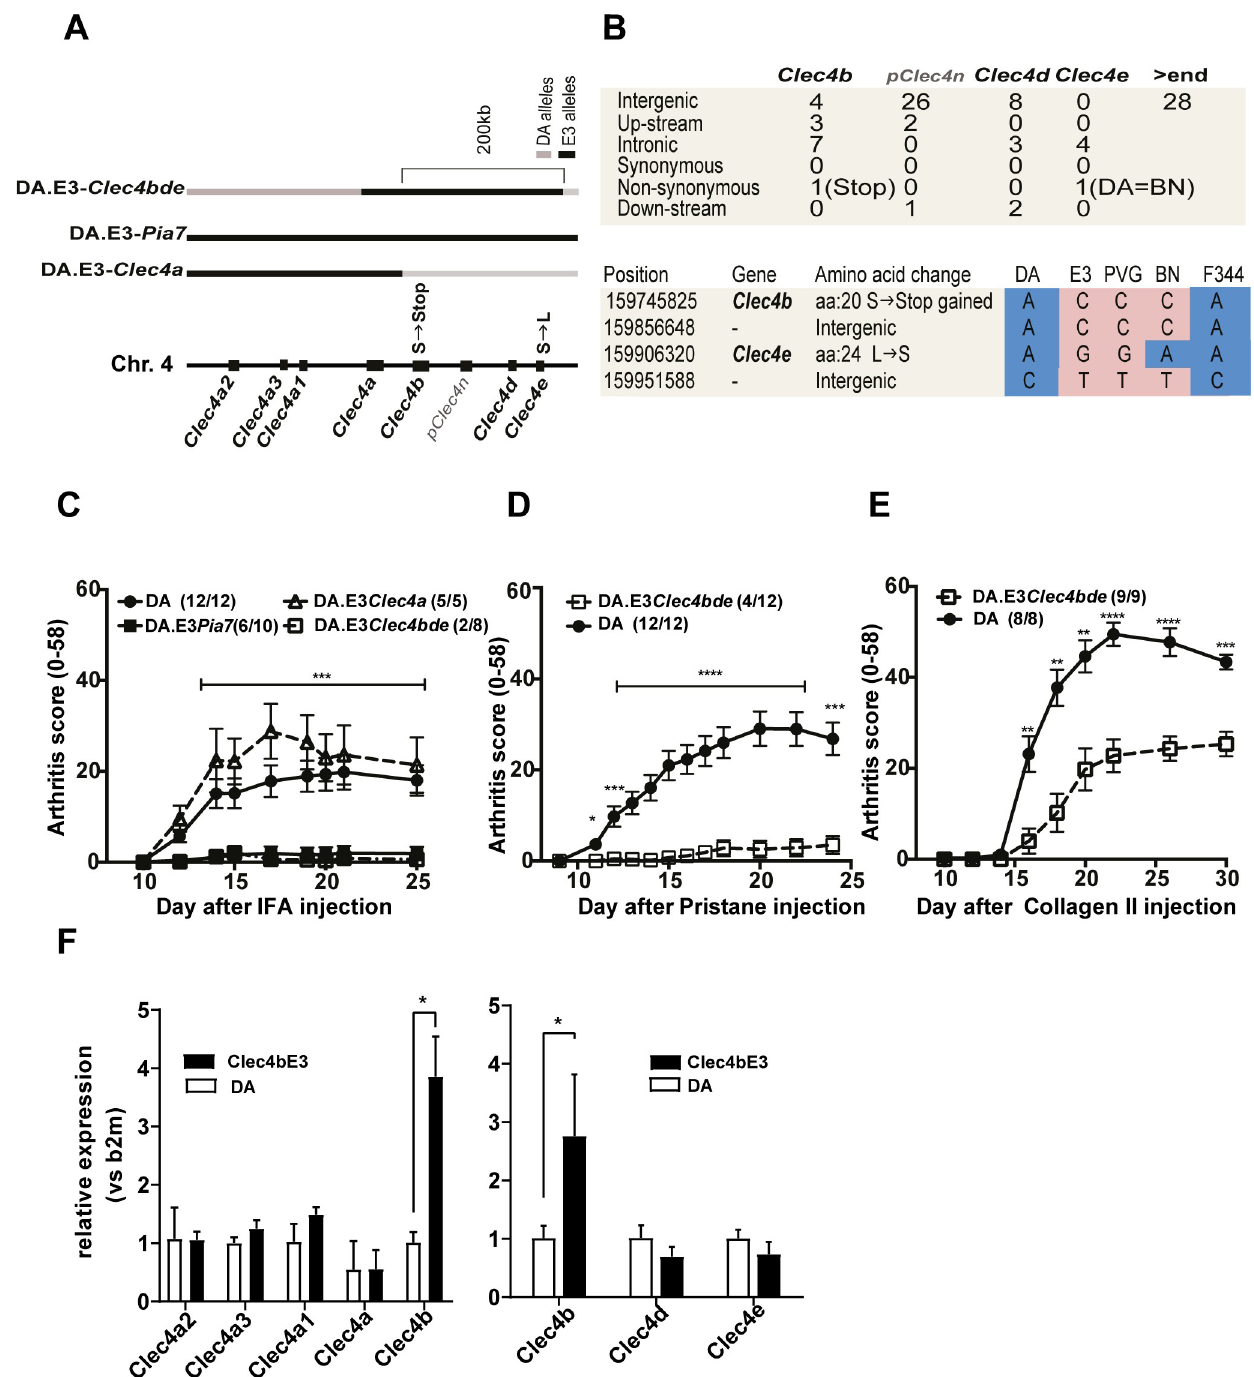
Fig 1. Identification of the arthritis-regulating gene in the Oia2/Pia7/Cia13 locus on rat chromosome 4. a) An illustration of the distribution of the 8 C- type lectin genes across the APLEC interval on rat chromosome 4 and the congenic fragments with genomic regions harboring arthritis-susceptible DA alleles (grey) and arthritis-protective E3 alleles (black) for the three congenic strains DA.E3- Pia7 to the far right, DA.E3- Clec4a to the left of the chromosome and DA.E3- Clec4bde to the far left. b) An illustration of the distribution of SNPs across the DA.E3- Clec4bde congenic fragment[6] and the Clec4bde encoded genes, together with an illustration of the two non-synonymous SNPs and nearby SNPs in five different inbred strains including the reference rat strain BN. c) OIA development in DA strain and the 3 congenic strains. d) PIA development over time in the original DA strain and DA.E3- Clec4bde congenic. e) CIA development over time for the DA strain and the DA.E3- Clec4bde strain. Significance stars illustrate Mann. Whitney Test � = p < 0 . 05 , �� = p < 0 . 01 , ��� = p < 0 . 001 ���� = p < 0 . 0001 and SEM. f) Gene expression of all APLEC encoded genes for DA and Clec4b E3 in na ï ve splenocytes. House-keeping gene is b2m and all genes are compared to one DA sample. https://doi.org/10.1371/journal.pgen.1008788.g001 PLOS Genetics | https://doi.org/10.1371/journal.pgen.1008788 June 4,